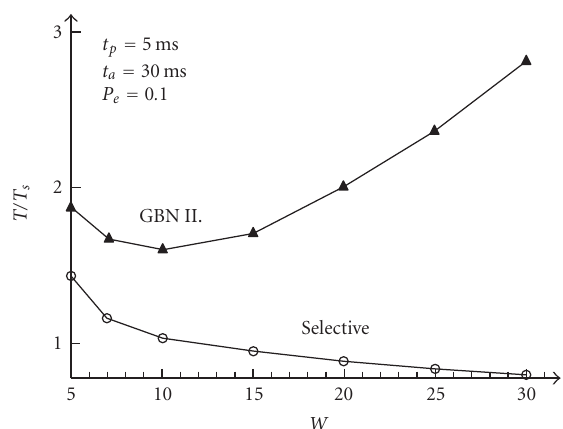
Figure 4: Behavior of Go-Back-N and selective schemes for di ff erent window